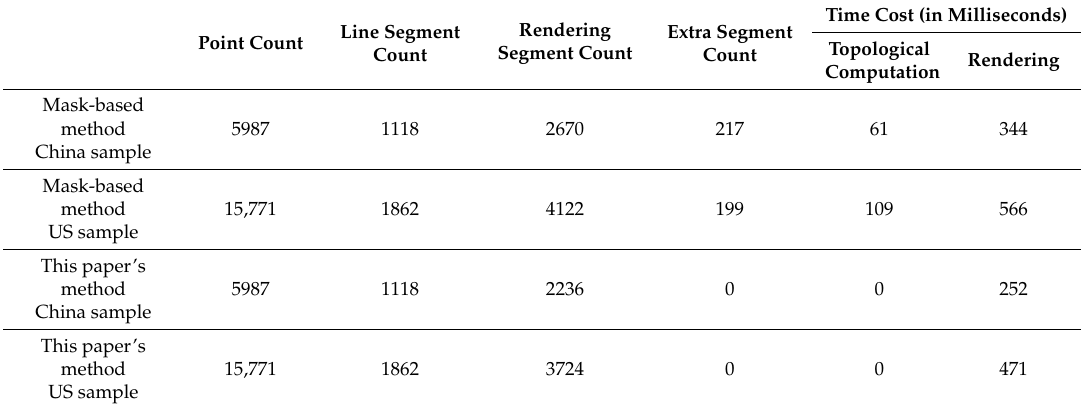
Table 1. Time costs of rendering the two experimental